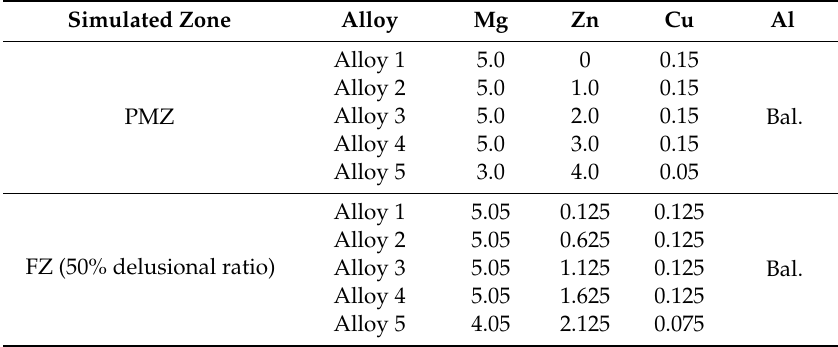
Table 3. Chemical compositions of the fusion zone (FZ) and the partially melted zone (PMZ) used for simulations (wt%).